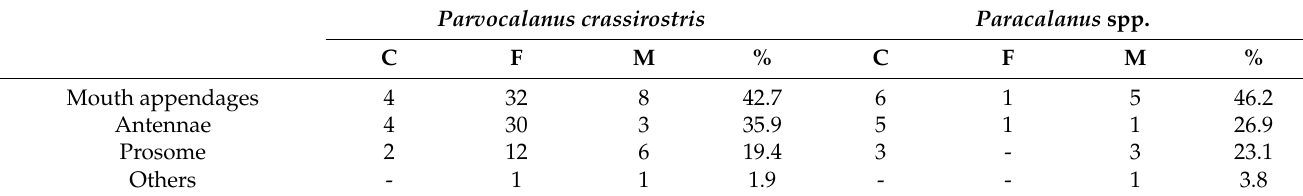
Table 4. Ellobiopsis chattoni adhesion sites on the host copepod species ( Parvocalanus crassirostris and Paracalanus spp.). C: juvenile copepodid, stages I to V; F: adult females; M: adult males; %: frequency of adhesion at each site. Parvocalanus